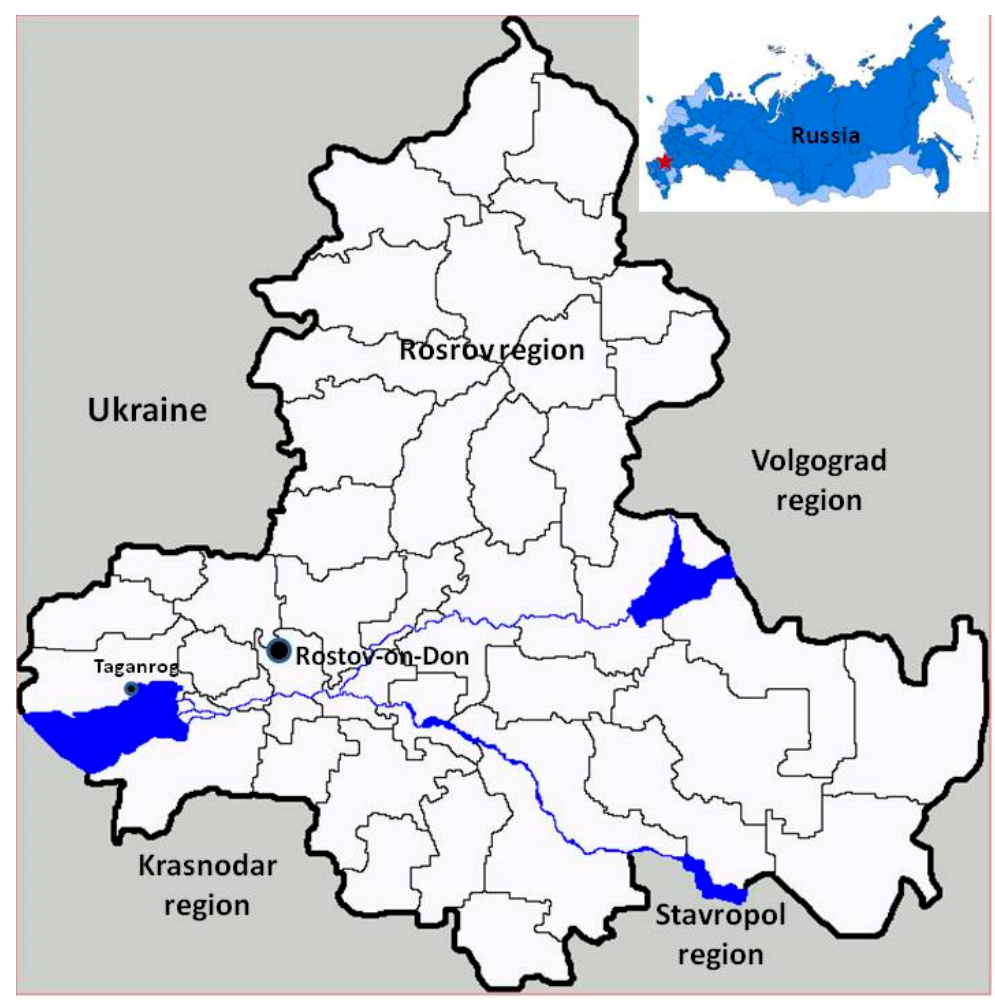
◦ 14 (cid:48) 10” N, 38 ◦ 53 (cid:48) 48”